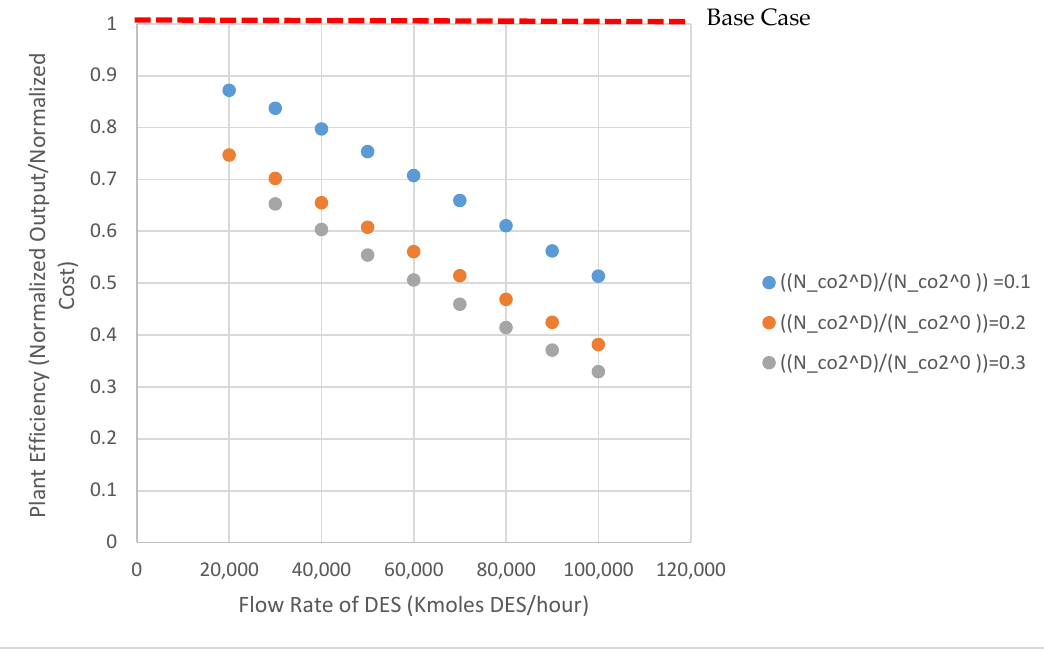
Figure 4. Relative plant efficiency for the METPB system; efficiency is calculated from the normalized output and cost values in Figure 3.